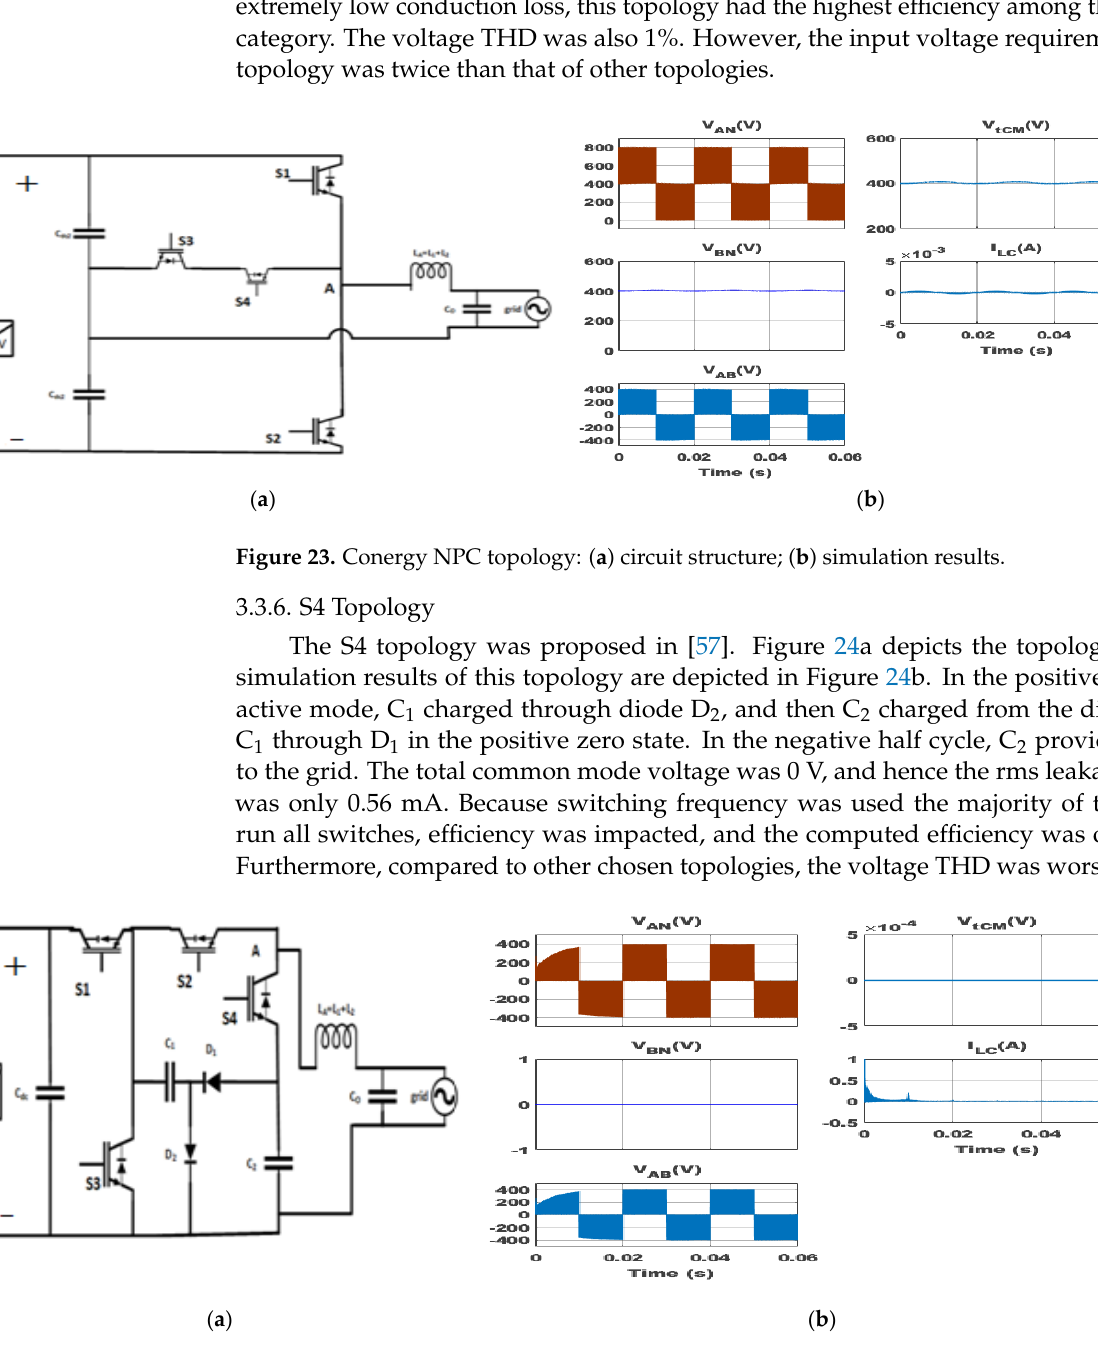
Figure 22. Siwakoti-H topology: ( a ) circuit structure; ( b ) simulation results.